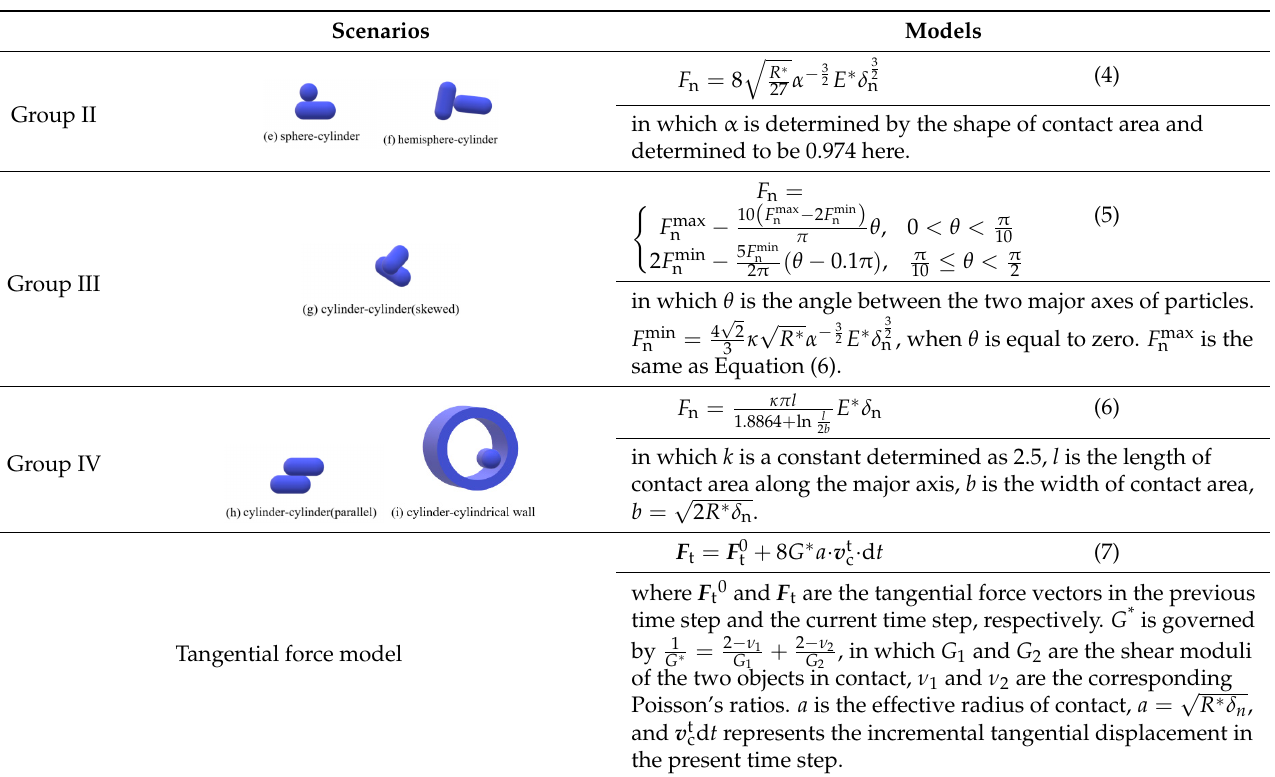
Table 1. Contact force models used in the DEM simulations.